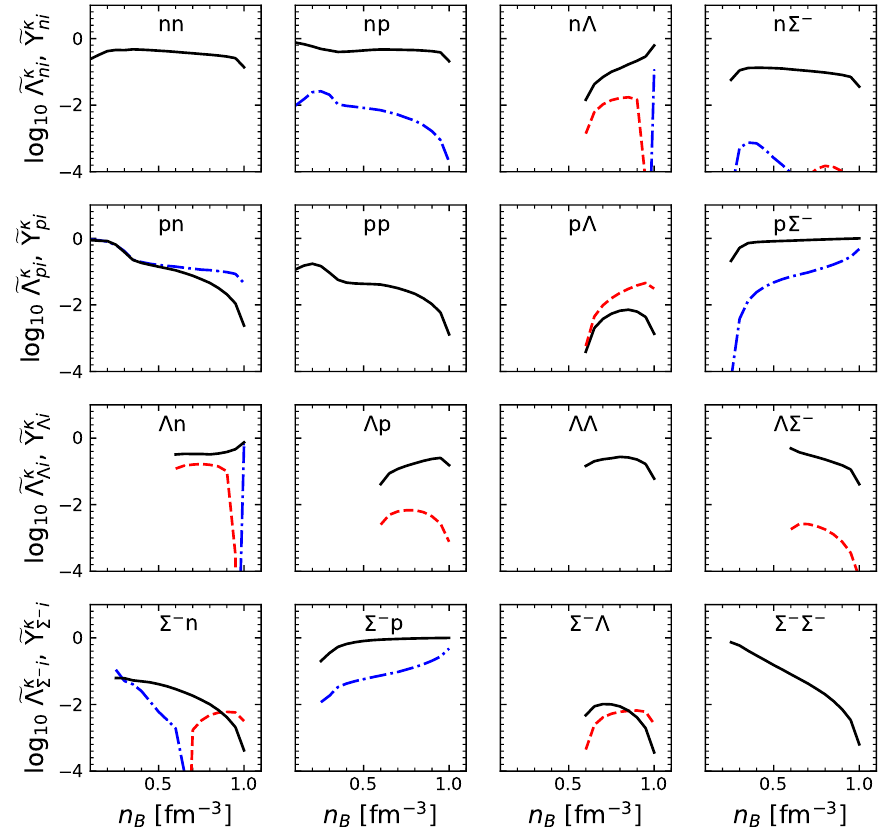
Figure 4. Normalized elements of the transport matrix for baryons for the thermal conductivity case and the NSC97e model. Solid lines in each row ( c = n , p , Λ , Σ − ) show relative contributions (cid:101) Υ κ to ci diagonal transport matrix elements from collisions with different baryon species. Other lines show the non-diagonal relative matrix elements (cid:101) Λ κ , where red dashed lines correspond to positive values ci and the blue dash-dotted ones to negative values, respectively. Only strong forces are included, see text for